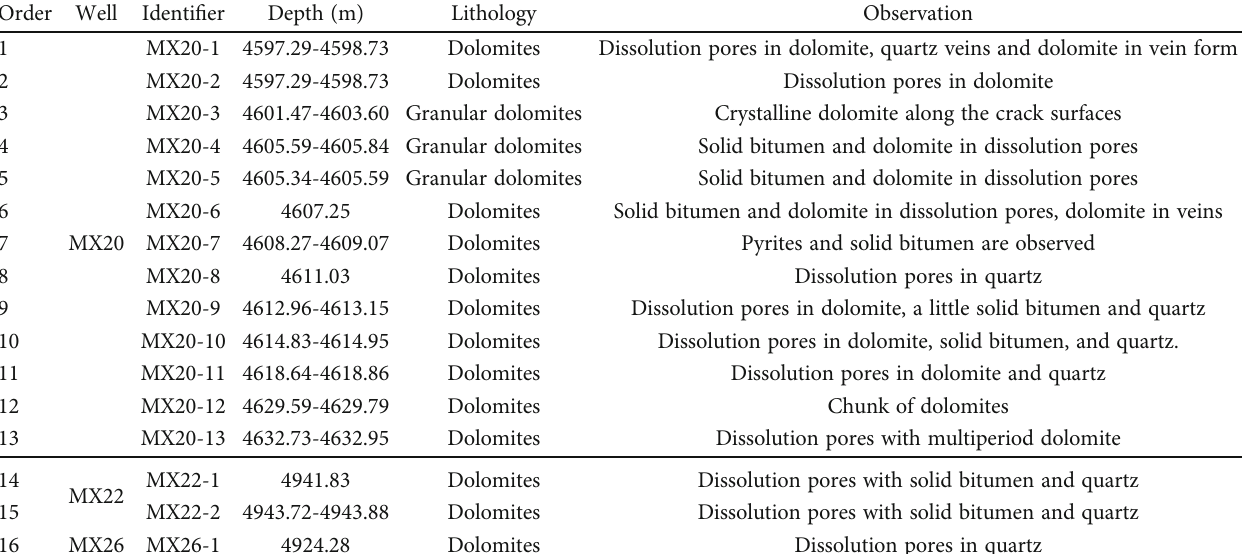
Table 1: List of core samples from the Longwangmiao Formation with associated description of observed pore fi ll and pore hosting alteration